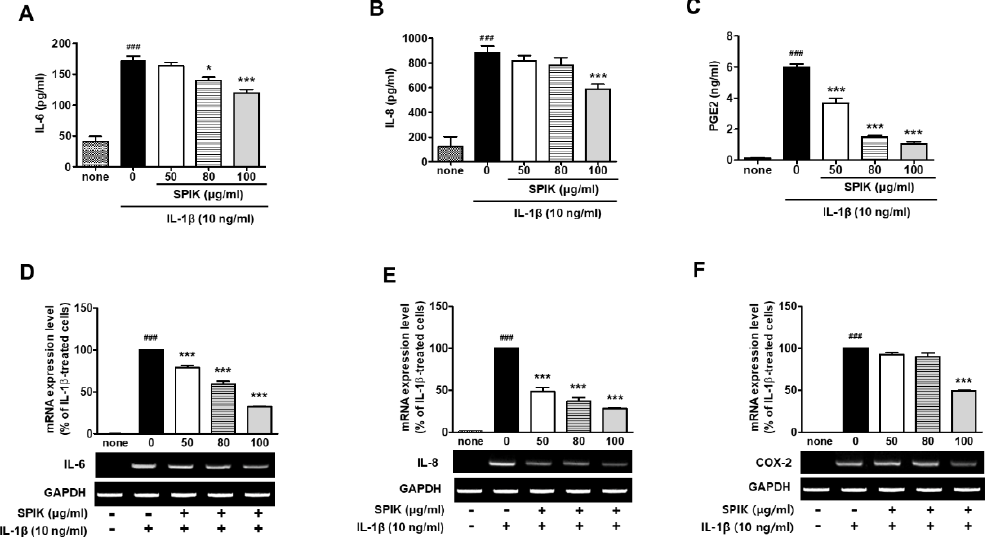
Figure 1. E ff ect of the 50% ethanolic extract of Manchurian spikenard on the IL-1 β -stimulated protein and / or mRNA expression levels of IL-6 ( A , D ), IL-8 ( B , E ) and COX-2 ( F ), and PGE2 synthesis ( C ) in human osteoarthritis (OA) chondrocytes. SPIK, Manchurian spikenard extract; PGE2, prostaglandin E2; COX, cyclooxygenase; GAPDH, glyceraldehyde 3-phosphate dehydrogenase. ### p < 0.001 vs. non-treated naïve cells (none); * p < 0.01 and *** p < 0.001 vs. the IL-1 β -treated cells without